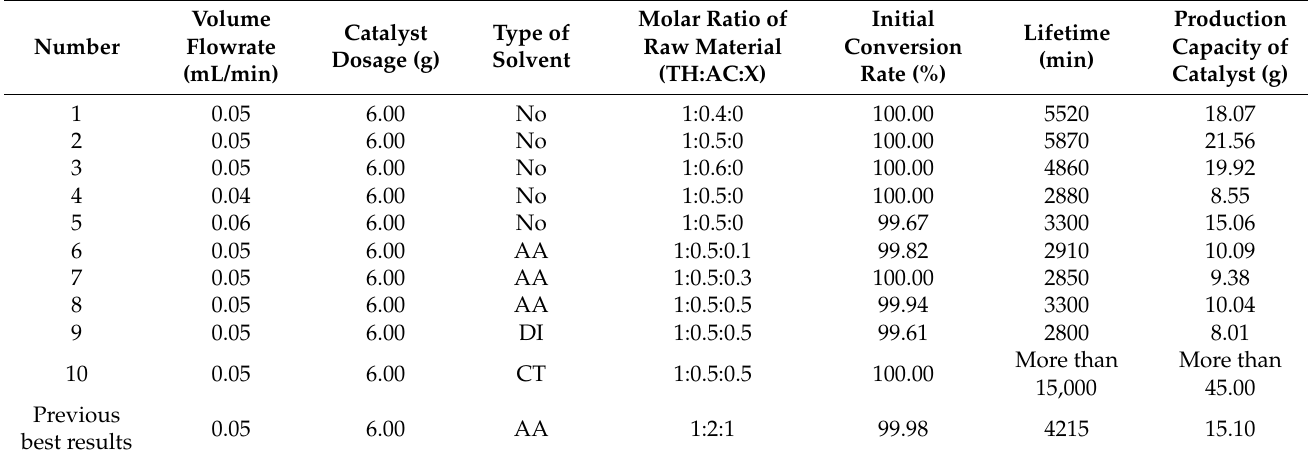
Table 2. The comparisons of results for different continuous